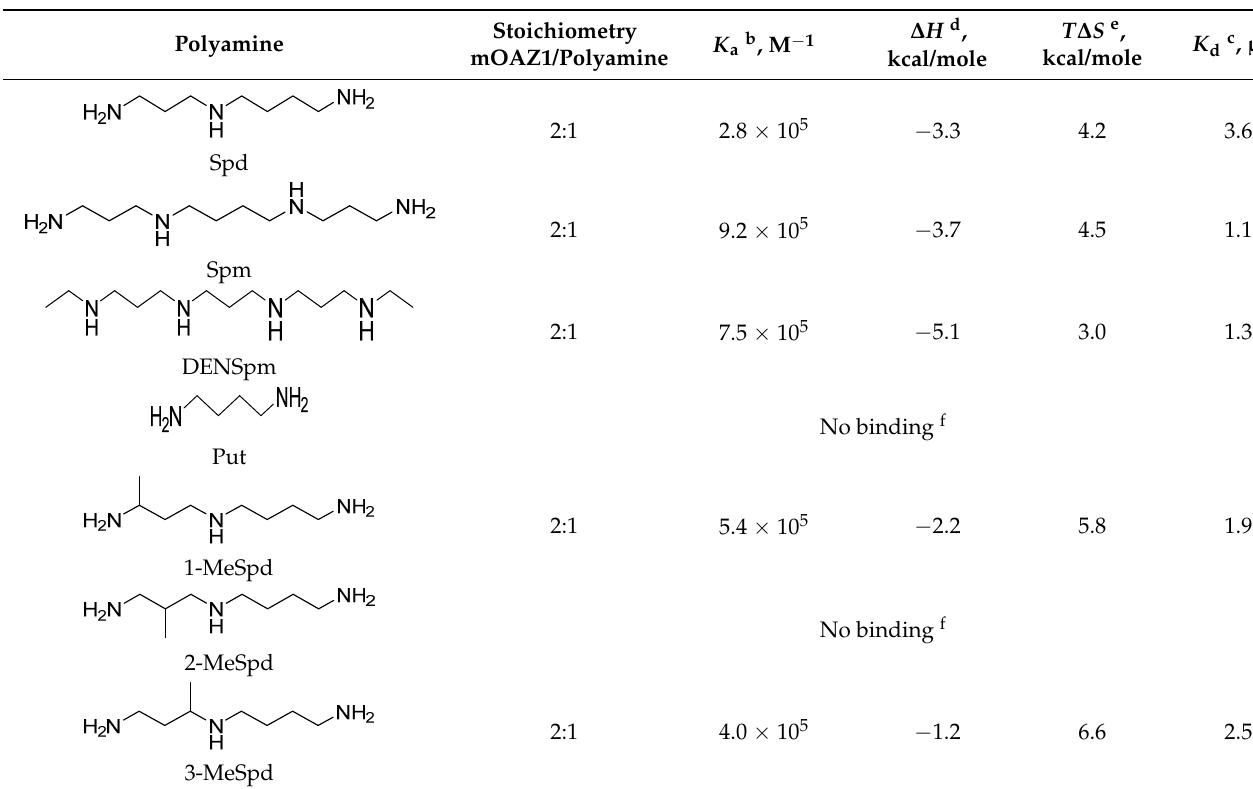
Table 1. Thermodynamic parameters of the polyamines binding to mOAZ1 as determined by iso- thermal titration calorimetry a .